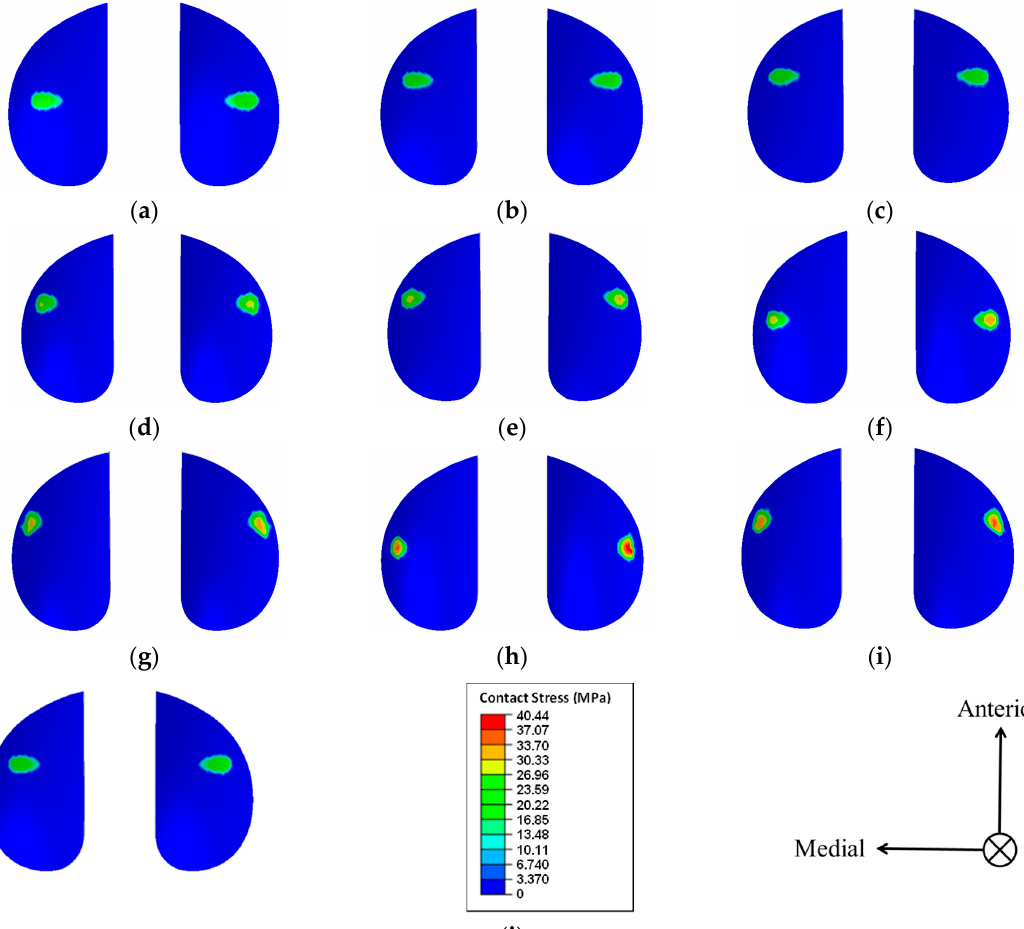
Figure 3. Distribution of the contact stress on the UHMWPE tibial insert. ( a ) Model of the A 1 B 1 C 1 group; ( b ) model of the A 1 B 2 C 2 group; ( c ) model of the A 1 B 3 C 3 group; ( d ) model of the A 2 B 1 C 2 group; ( e ) model of the A 2 B 2 C 3 group; ( f ) model of the A 2 B 3 C 1 group; ( g ) model of the A 3 B 1 C 3 group; ( h ) model of the A 3 B 2 C 1 group; ( i ) model of the A 3 B 3 C 2 group; and ( j ) model of the A 1 B 1 C 2 group (opti-